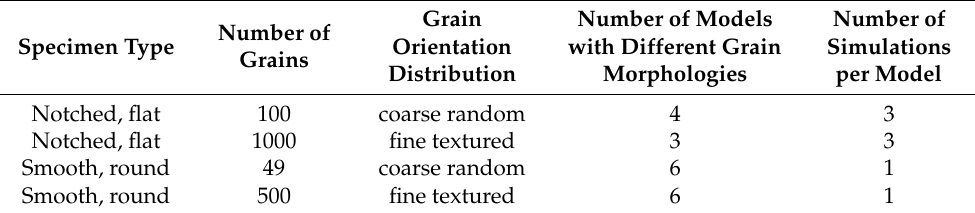
Table 2. Overview of the different numerical